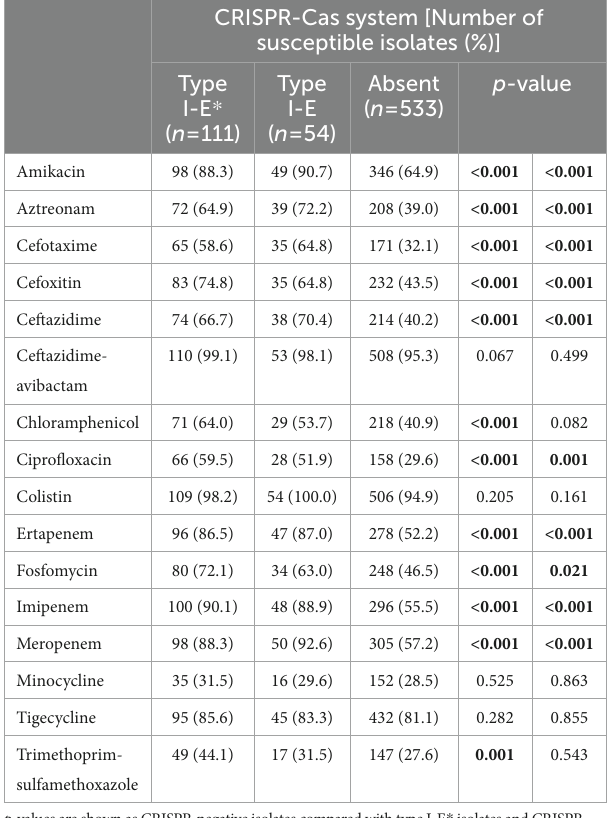
TABLE 1 The association of antimicrobial susceptibilities with CRISPR- Cas systems in clinical isolates of Klebsiella pneumoniae . CRISPR-Cas system [Number of susceptible isolates (%)]